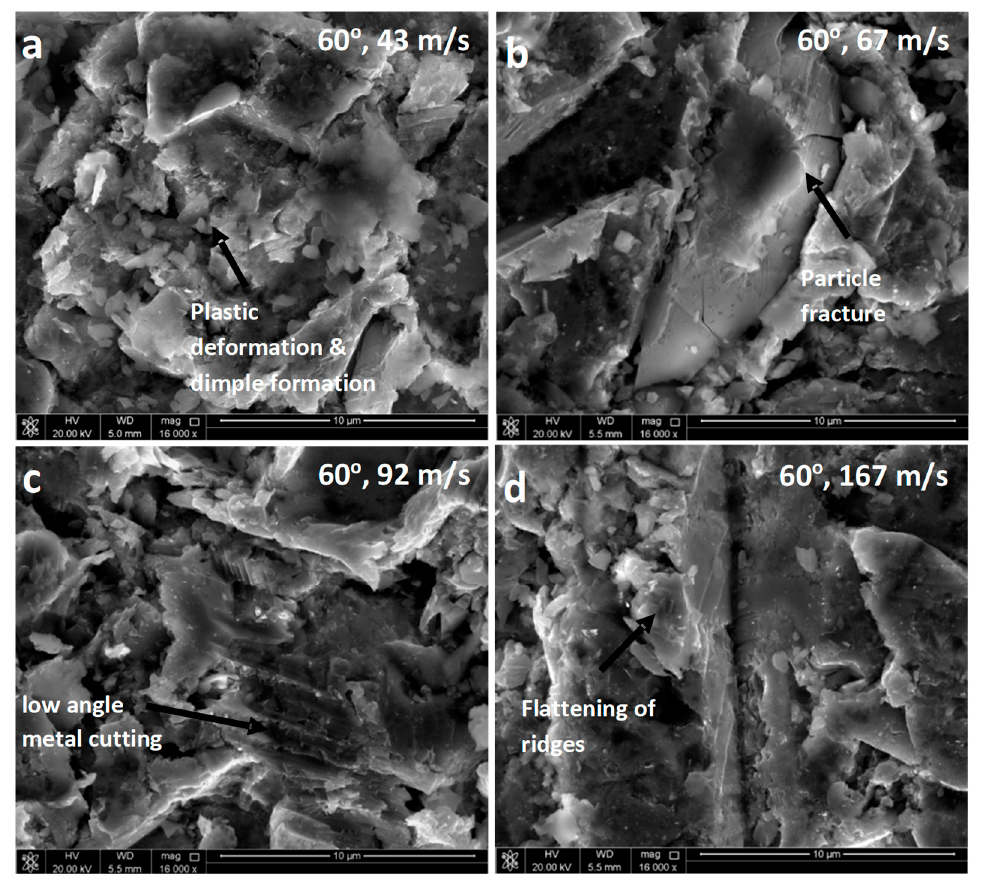
Figure 8. SEM micrograph of steel specimen after erosion at 60° impact angle and different particle speeds of ( a ) 43 m·s − 1 , ( b ) 67 m·s − 1 , ( c ) 92 m·s − 1 , ( d ) 167 m·s − 1 .